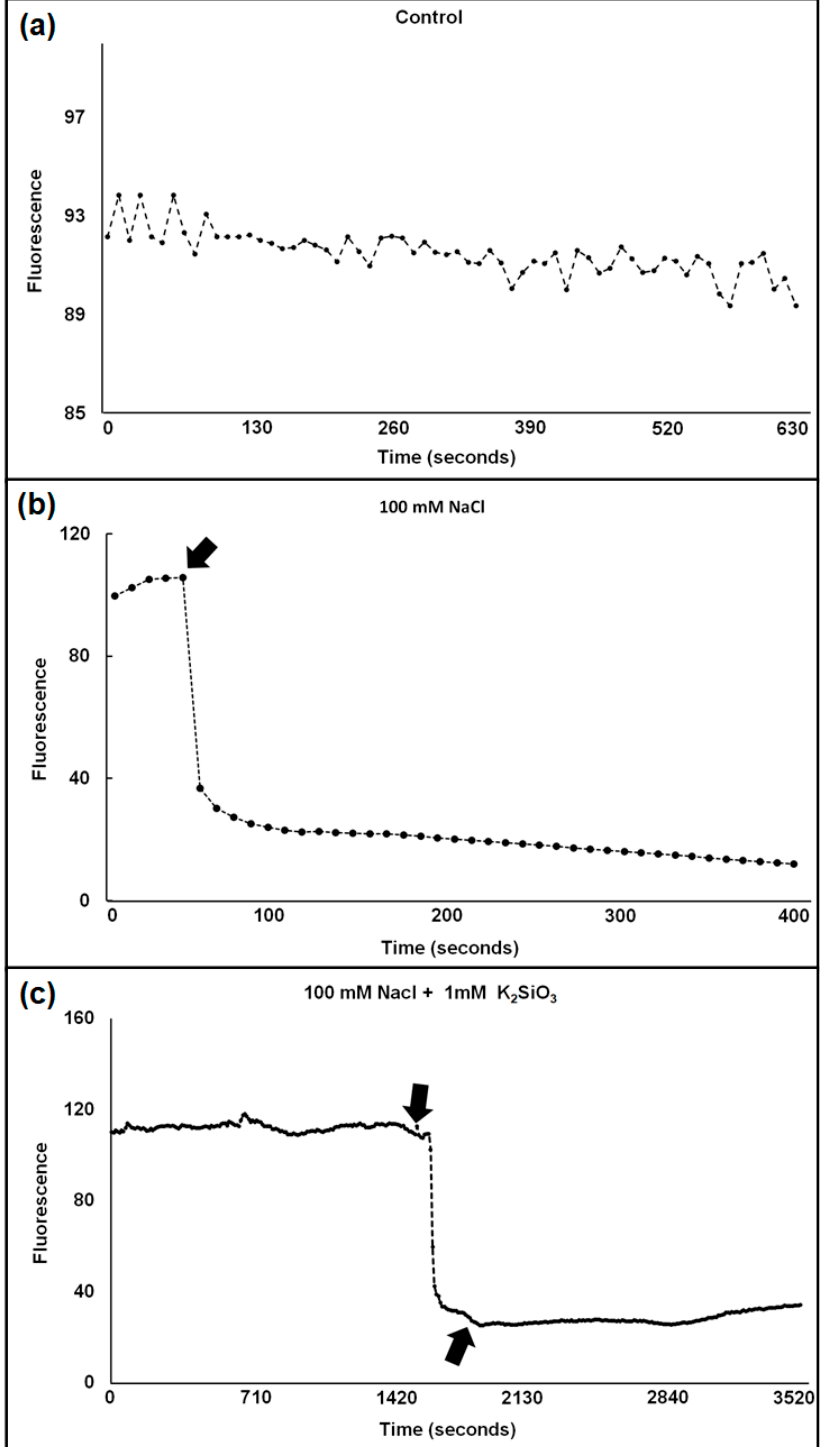
Figure 1. ( a – c ) Typical traces show the influx of Cl − into the cytosol of a wheat protoplast in the absence of NaCl ( a ), in the presence of 100 mM NaCl ( b ), and in the presence of 100 mM NaCl + 1 mM K 2 SiO 3 ( c ). Arrows indicate addition of NaCl ( b ) and of NaCl + 1 mM K 2 SiO 3 ( c ). Excitation and emission wavelengths were 350 ± 10 and 460 ± 10, respectively.